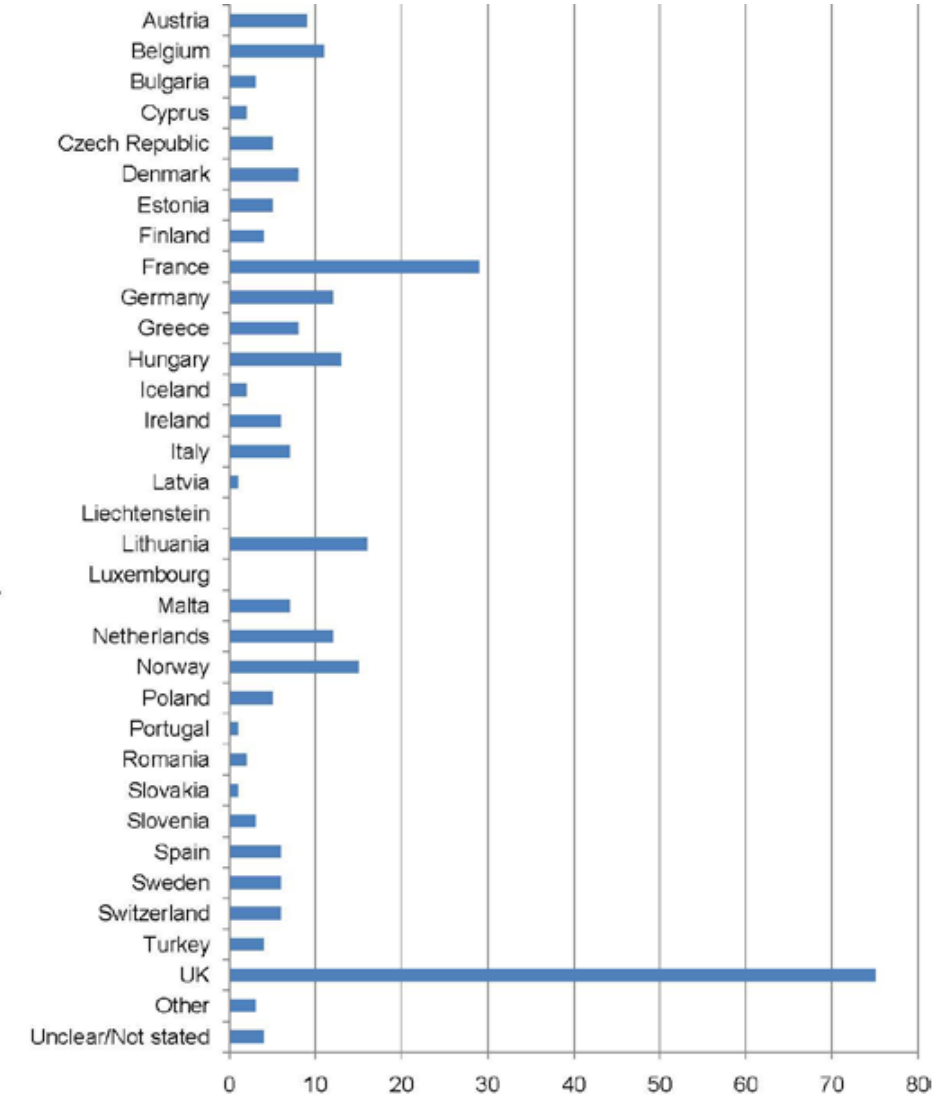
Figure 3: Countries in which activities are